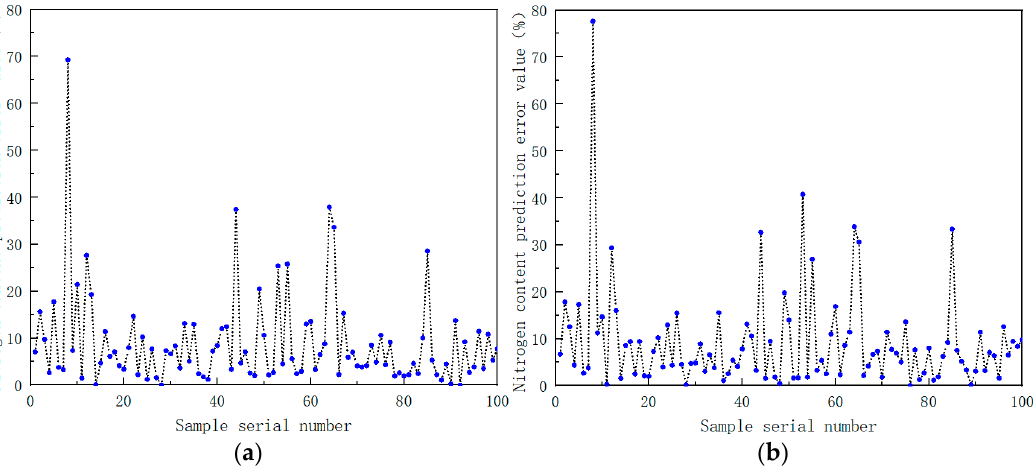
Figure 16. ( a ) Prediction results of soil nitrogen content using support vector machine model based on linear kernel function; ( b ) prediction results of soil nitrogen content using support vector machine model based on Gaussian kernel function.